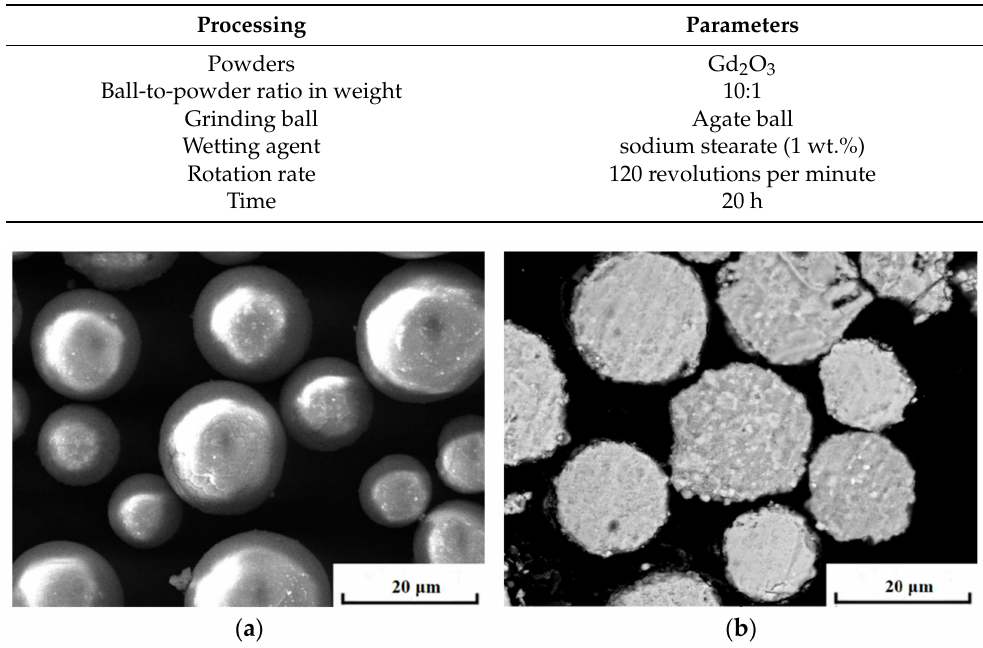
Table 1. Ball-milling parameters of the powders.